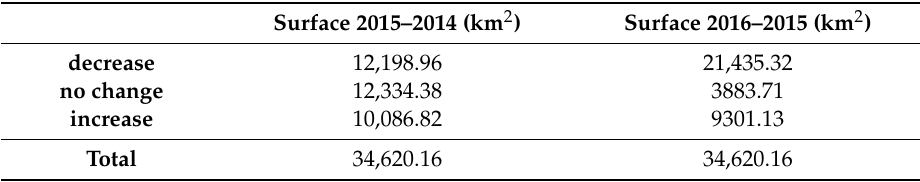
Table 7. Surface a ff ected by changes resulting from the image di ff erencing